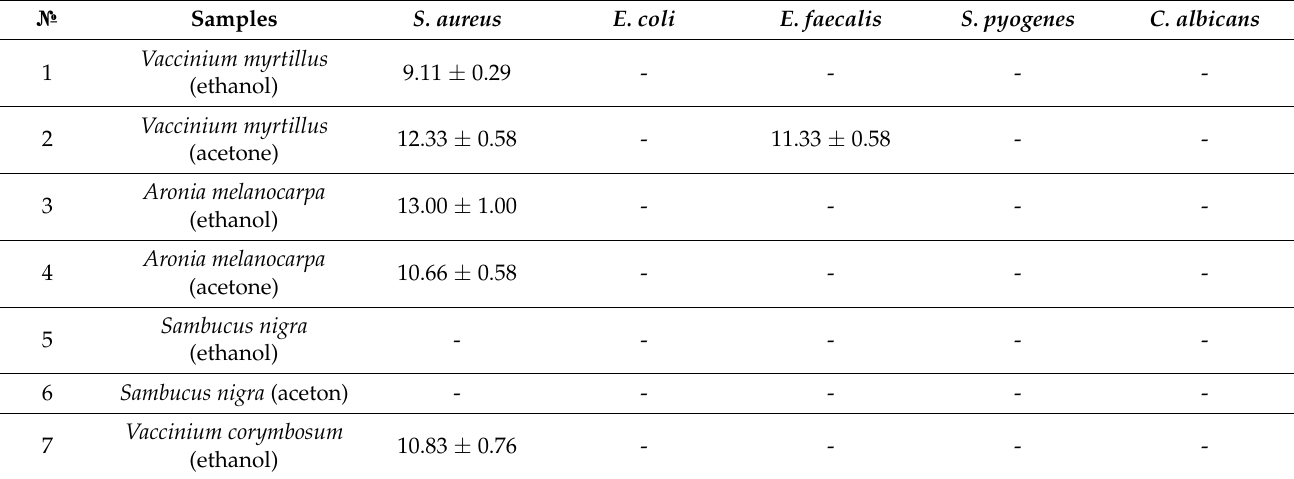
Table 7. Antimicrobial activity of anthocyanins against clinical strains, zones inhibition in millimeters including diameter of well, mm (n = 3, x ± SD). ( − : no